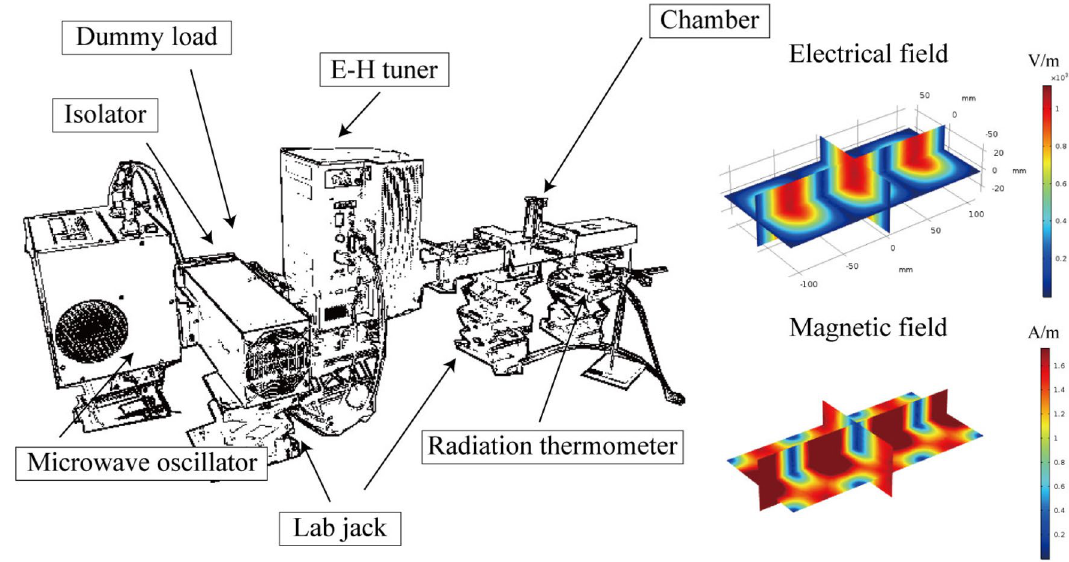
Figure 1. Schematic illustration of the single-mode heating device and the calculated electromagnetic field intensity distribution inside the device during microwave irradiation. The microwave power is assumed to be 1